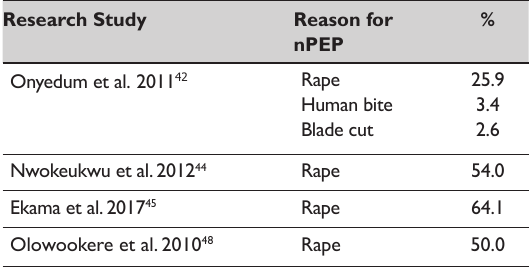
Table 2: Reasons for HIV Non-occupational Post Exposure